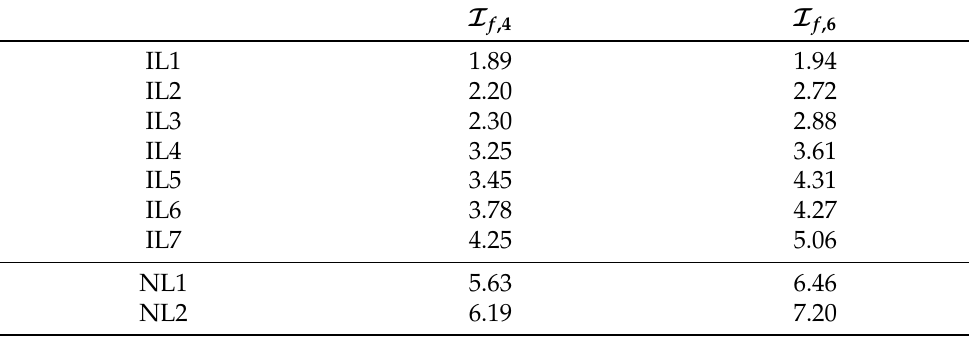
Table 6. Data analysis for swimmers IL1–IL7 and NL1–NL2: values of indices (23) and